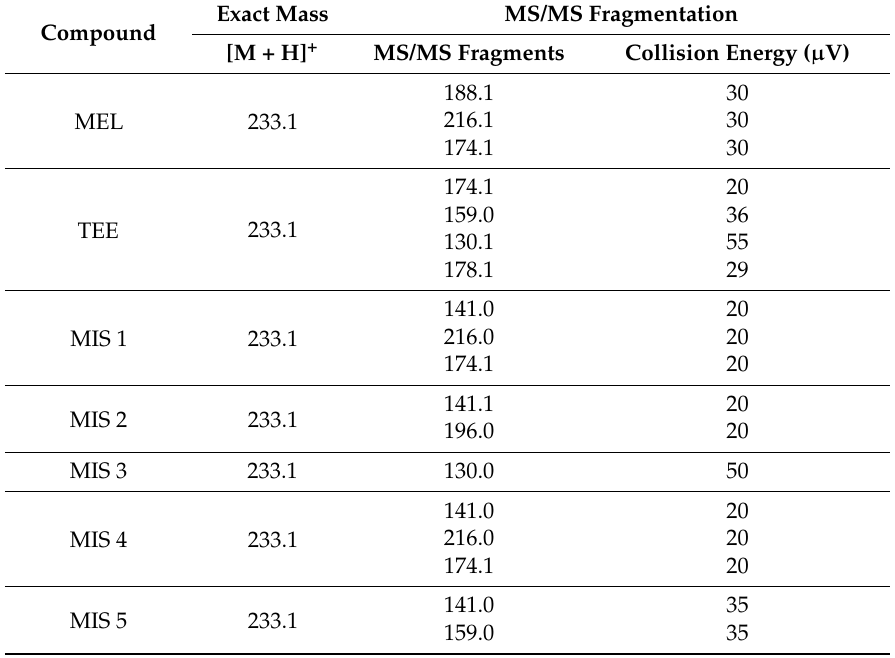
Table 3. Identification of MEL (melatonin), TEE (tryptophan ethyl ester), and MISs (MEL isomers) by